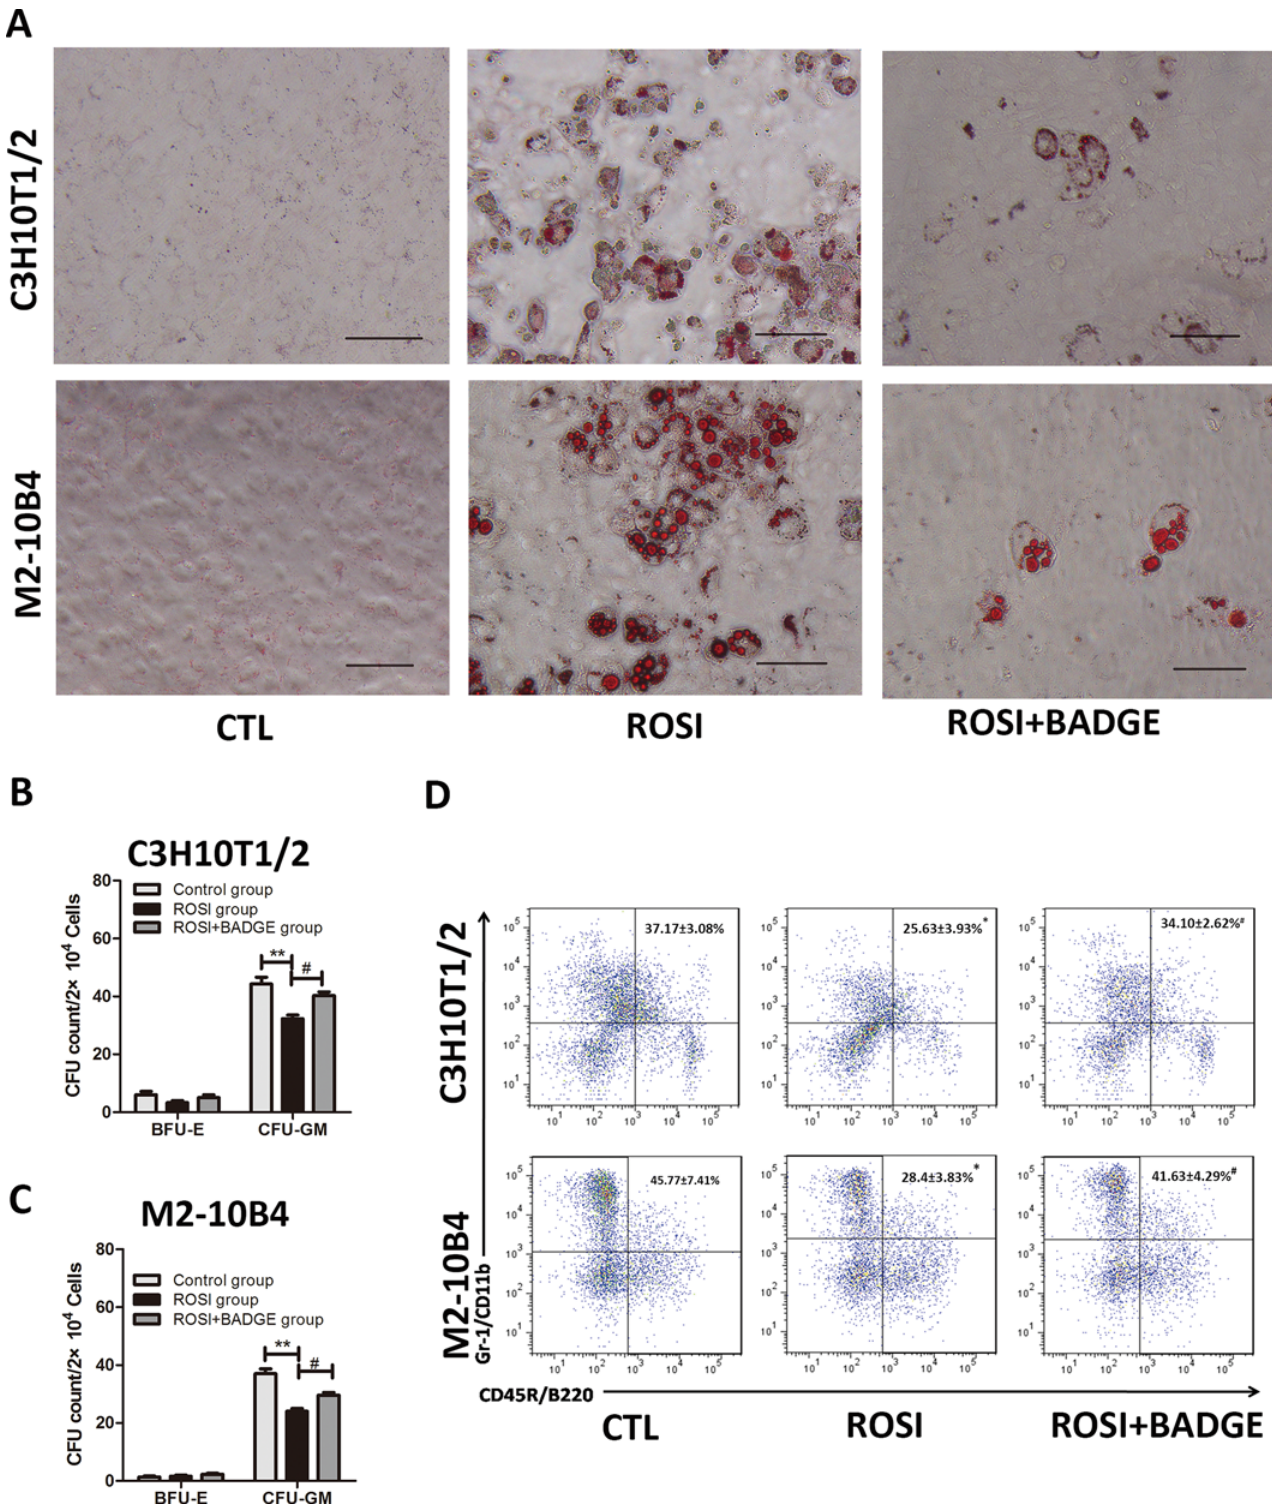
Fig 5. The effect of rosiglitazone-treated stromal cells on myeloid differentiation in HSPCs. (A) C3H10T1/2 cells and M2-10B4 were treated with 10 μ M rosiglitazone in the presence or absence of BADGE(20 μ M). After 12 days of culture, the cells were fixed, and adipogenic differentiation was determined by Oil red O staining of the lipid droplets(scale bar 100 μ m). (B, C) C3H10T1/2 cells and M2-10B4 were treated with 10 μ M rosiglitazone in the presence